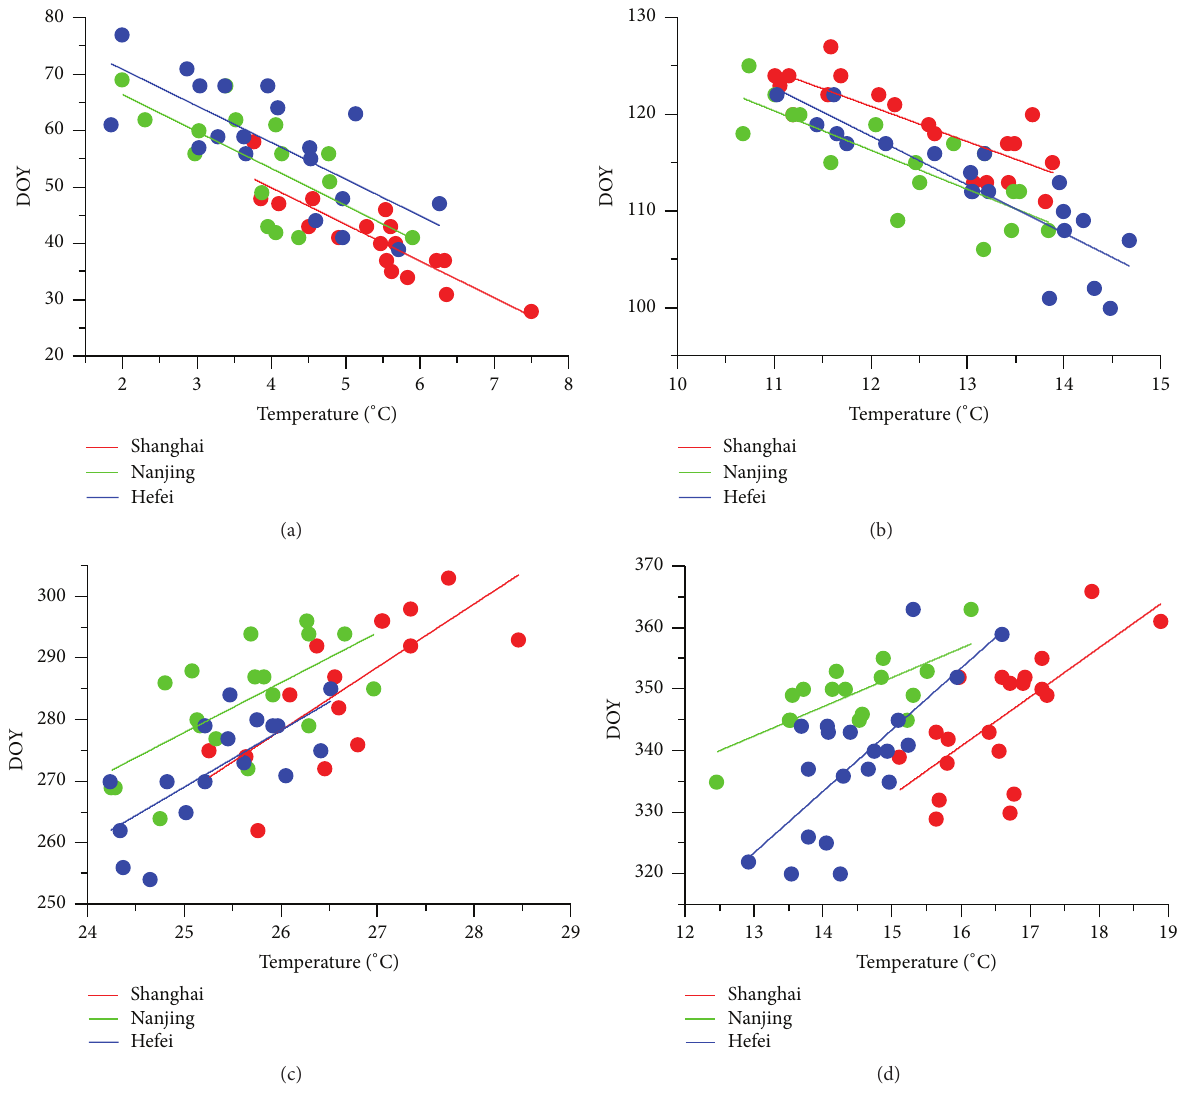
Figure 4: Linear correlation analysis between the beginning time of phenological season and the mean temperature of the previous 60 days in 1987–2012. (a) Spring, Shanghai: 𝑦 = −6.51𝑥 + 75.86 ( 𝑅 2 = 0.77 , 𝑃 < 0.01 ); Nanjing: 𝑦 = −6.55𝑥 + 79.45 ( 𝑅 2 = 0.47 , 𝑃 < 0.05 ); and Hefei: 𝑦 = −6.49𝑥 + 83.79 ( 𝑅 2 = 0.53 , 𝑃 < 0.01 ). (b) Summer, Shanghai: 𝑦 = −3.65𝑥 + 164.59 ( 𝑅 2 = 0.67 , 𝑃 < 0.01 ); Nanjing: 𝑦 = −4.06𝑥 + 164.94 ( 𝑅 2 = 0.64 , 𝑃 < 0.01 ); and Hefei: 𝑦 = −5.02𝑥 + 177.93 ( 𝑅 2 = 0.77 , 𝑃 < 0.01 ). (c) Autumn, Shanghai: 𝑦 = 10.27𝑥 + 11.22 ( 𝑅 2 = 0.55 , 𝑃 < 0.05 ); Nanjing: 𝑦 = 8.13𝑥 + 74.72 ( 𝑅 2 = 0.44 , 𝑃 < 0.05 ); and Hefei: 𝑦 = 9.22𝑥 + 38.44 ( 𝑅 2 = 0.53 , 𝑃 < 0.001 ). (d) Winter, Shanghai: 𝑦 = 8.00𝑥 + 212.65 ( 𝑅 2 = 0.48 , 𝑃 < 0.05 ); Nanjing: 𝑦 = 4.76𝑥 + 280.48 ( 𝑅 2 = 0.54 , 𝑃 < 0.05 ); and Hefei: 𝑦 = 10.00𝑥 + 193.34 ( 𝑅 2 = 0.53 , 𝑃 < 0.05